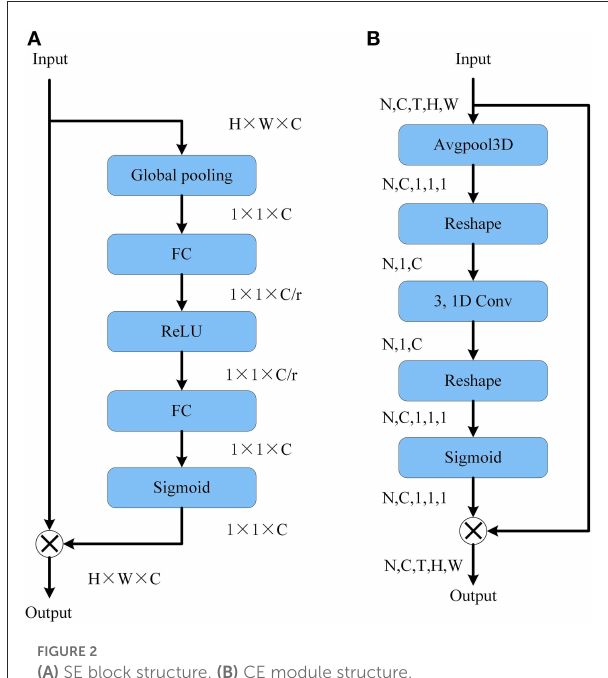
FIGURE2 (A) SE block structure. (B) CE module